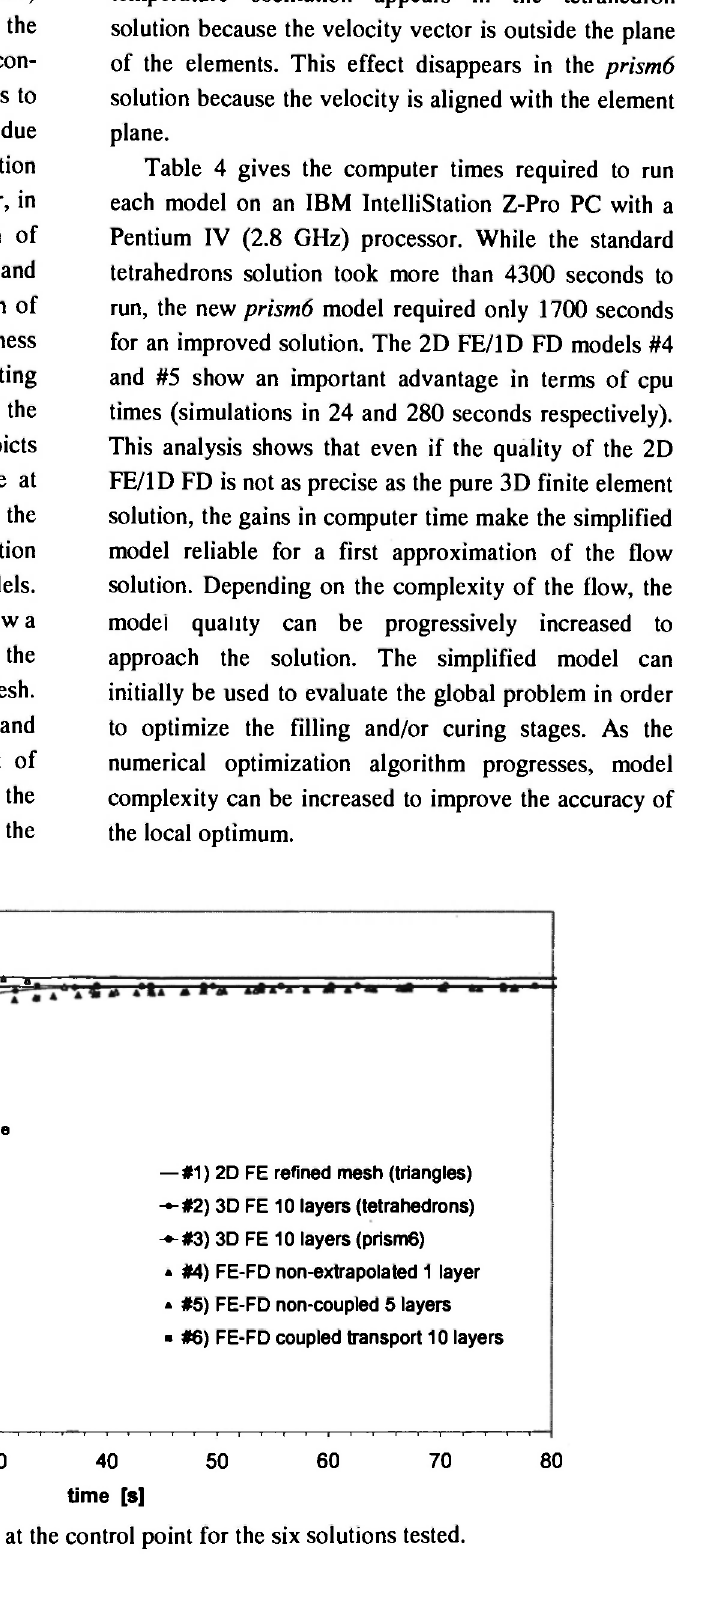
Fig. 20: Temperature evolution at the control point for the six solutions